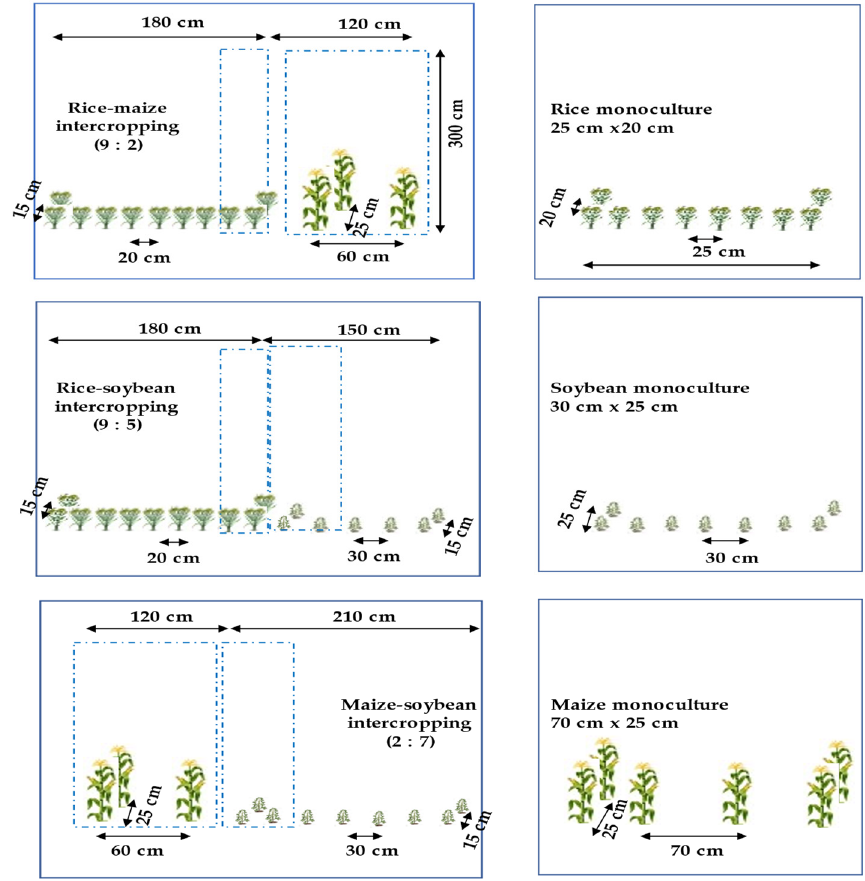
Figure 3. Schematic representation of the rice–maize, rice–soybean, and maize–soybean intercropping patterns, and sampling unit (blue dashed lines).